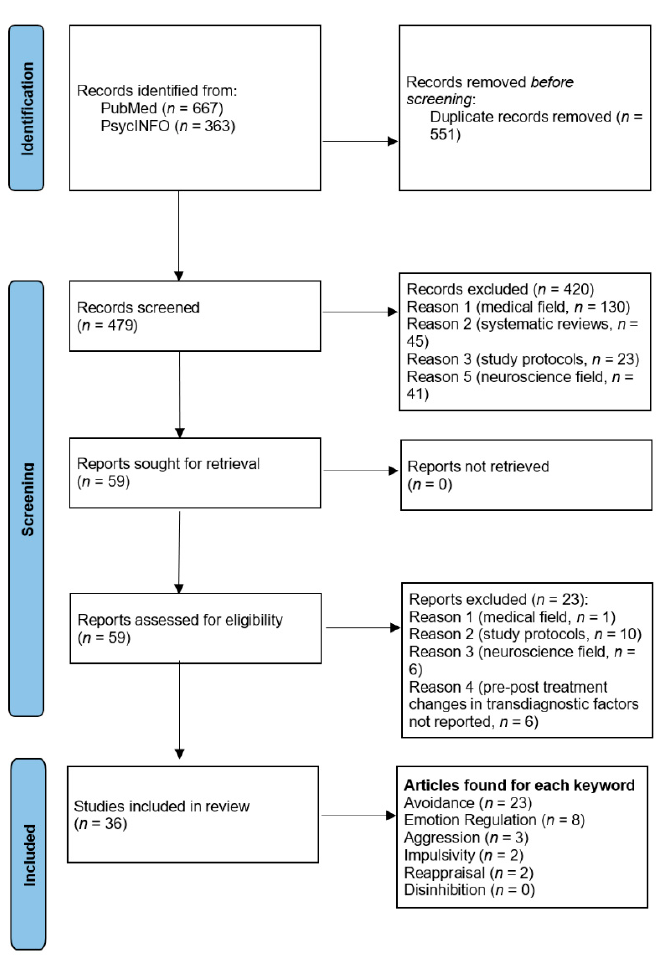
Figure 1. PRISMA flow diagram summarizing the article selection process [25].